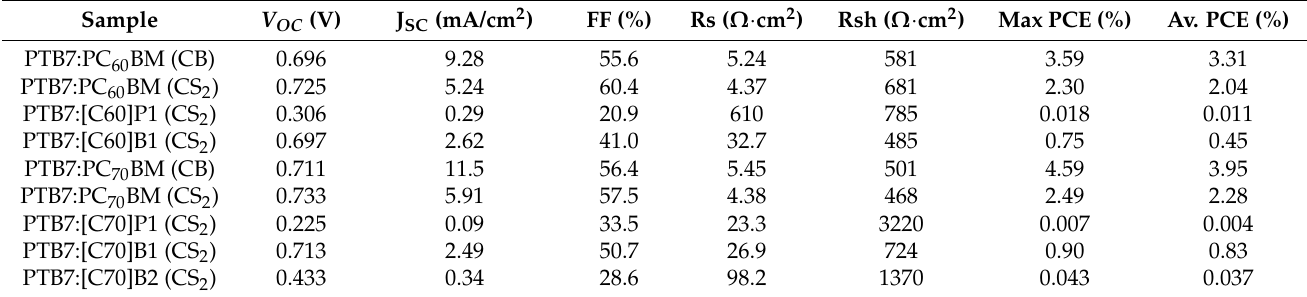
Figure 5. Current-voltage characteristics of solar cells with fullerene derivatives: ( A ) C 60 , ( B ) C 70 . Table 2. Electrical parameters of solar cells constructed using investigated C 60 and C 70 fullerene derivatives. Voc-open- circuit volage, Jsc-short circuit current density, FF-fill factor, Rsh and RS-shunt and serial resistivities, max PCE and avg PCE-maximal and averaged (over 8 pixels)